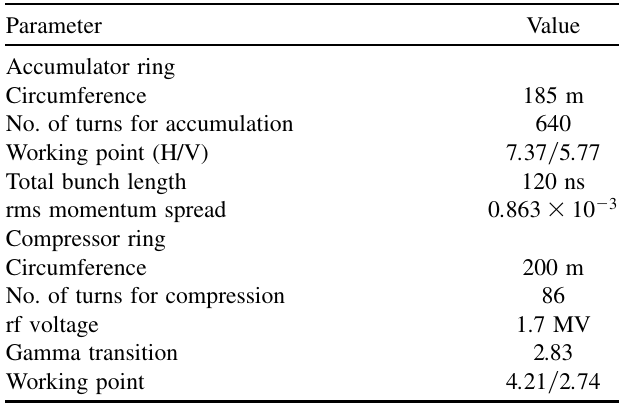
TABLE II. Parameters of the accumulator and compressor rings for the CERN proton-driver